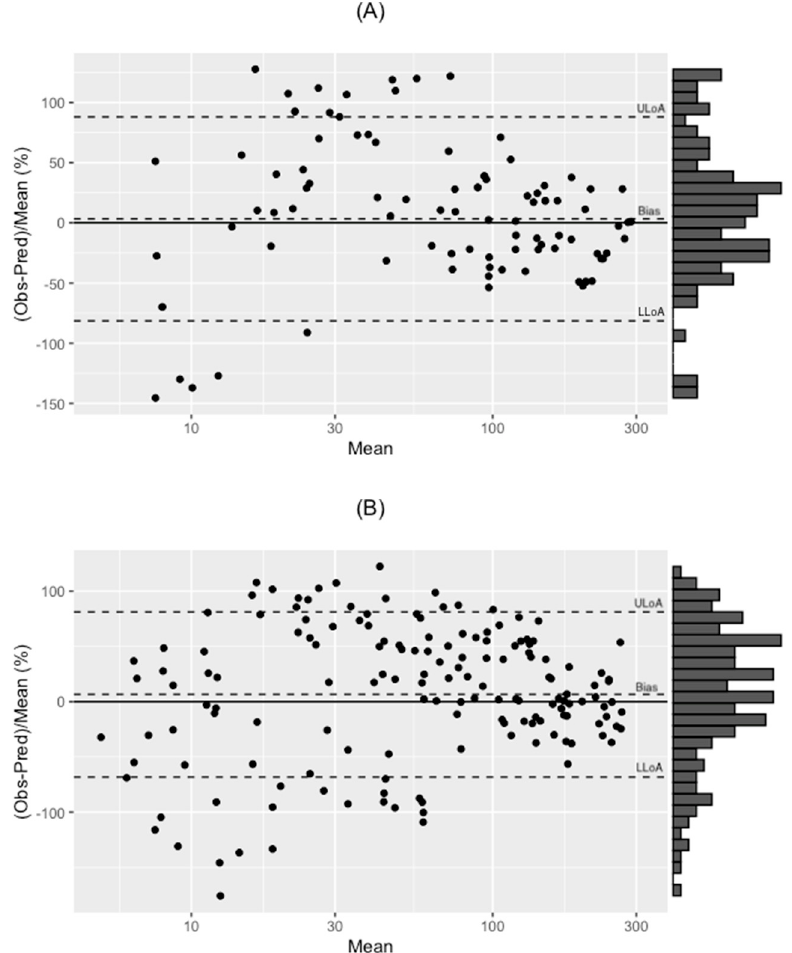
Figure 3. External validation plots from: ( A ) Udy et al. [16], Bias 3.3% ULoA (+1.96SD) of 88% and LLoA ( − 1.96SD) of − 81%, and ( B ) Tsai et al. [17], Bias 6.5% ULoA (+1.96SD) of 81% and LLoA ( − 1.96SD) of − 68%. Bland-Altman plot.